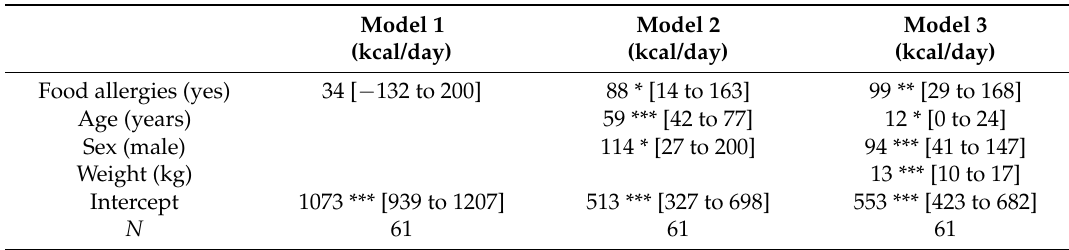
Table 3. Association between food allergies and resting energy expenditure (REE): 50th percentile (median) regression